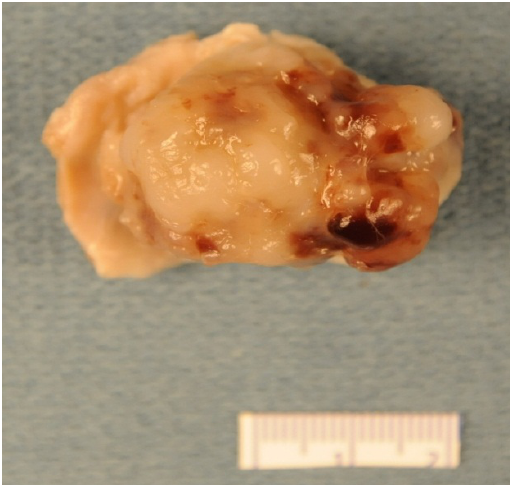
Figure 1. Gross picture of myxoma that is round to oval in shape and has smooth or slightly bosselated surface.